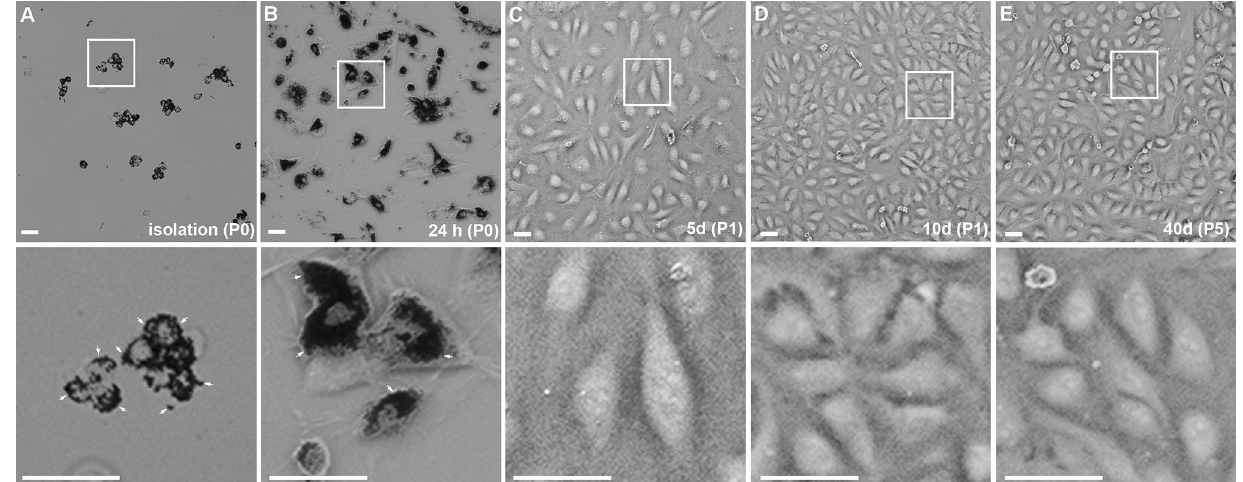
Figure 2. Isolation of endothelial cells with CD31 conjugated Dynabeads ( A ) and subsequent cultivation for 24 h, 5 days and 10 days. ( B ) 24 h after seeding, the cells with the bound Dynabeads (black dots, small arrows) have attached to the cell culture plate. ( C ) Following the first passaging 3 days after seeding, most of the Dynabeads were detached due to the trypsinization-process. At day 5, the endothelial cells proliferated ( C ) and showed vortical cell alignment when reaching confluency after 10 days ( D ). Following 5 passages, the proliferation rate declined but the ECs showed no signs of senescence ( E ). These results were reproduced four times with ECs derived from four independent isolation procedures of individual patients. Scale: 50